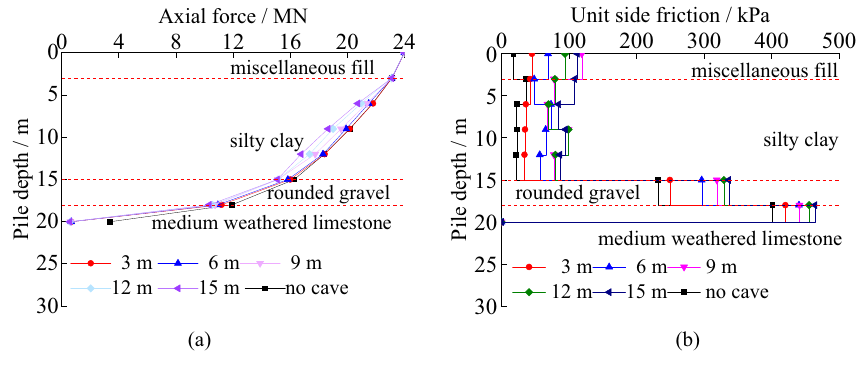
Figure 10. The load transfer characteristics of piles under different cave height: ( a ) axial force; ( b ) unit side